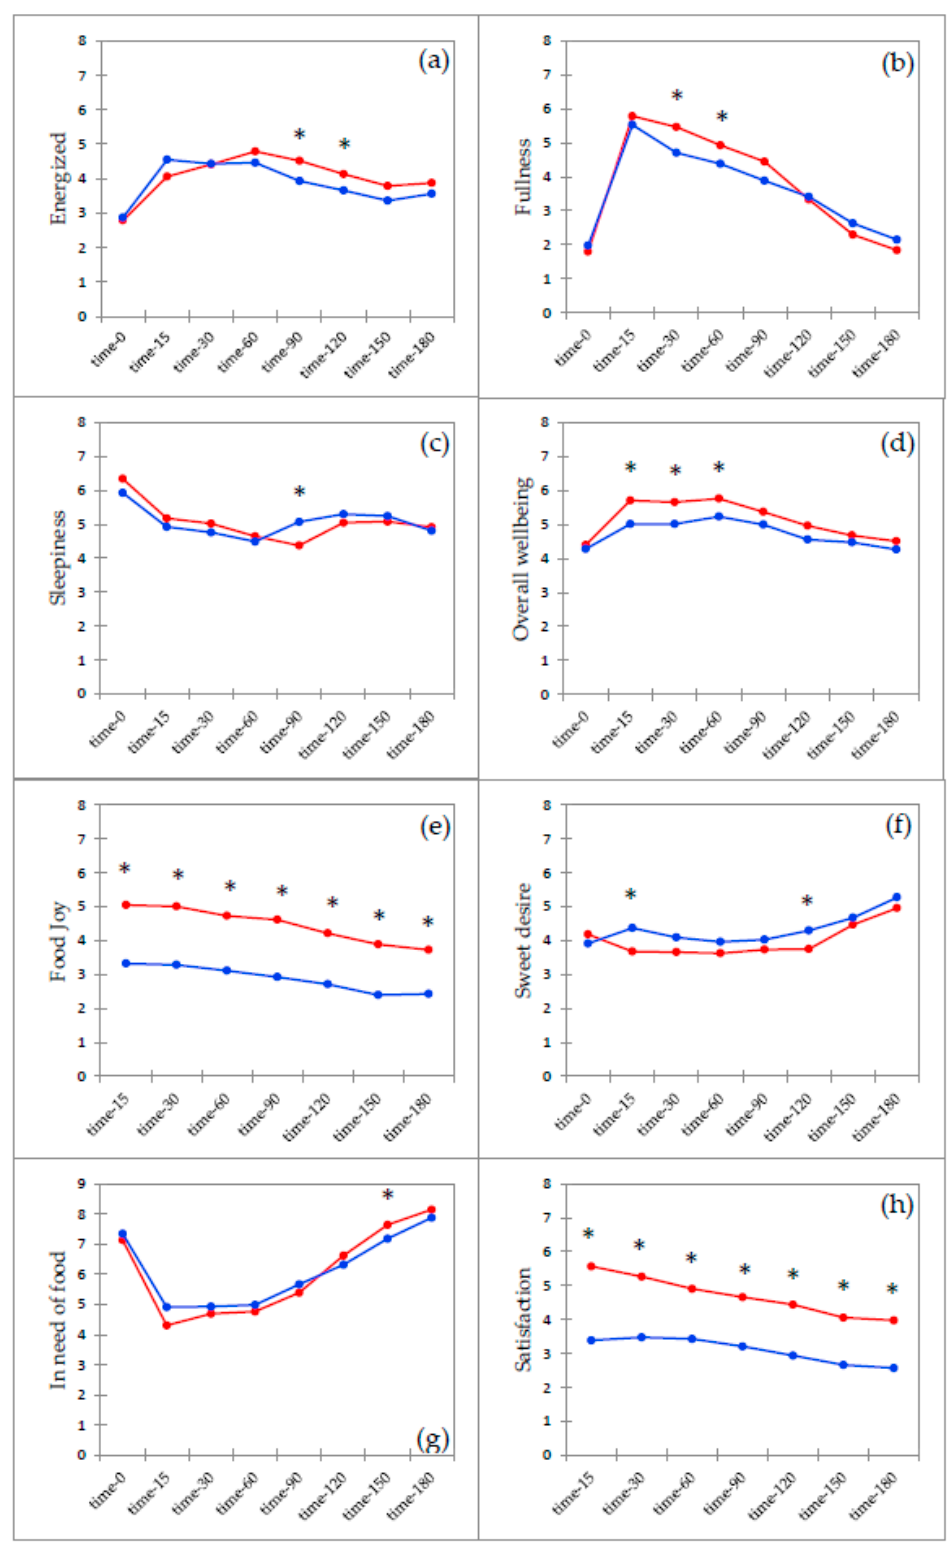
Figure 2. Post-ingestive responses at time-0 (pre intake),15,30,60,90,120,150,180 for Energized ( a ), Fullness ( b ), Sleepiness ( c ), Overall wellbeing ( d ), Food joy ( e ), Sweet desire ( f ), In need of food ( g ), Satisfaction ( h ). Red = High-carbohydrate test meal, Blue = High-protein test meal. Asterisk (*) indicates significant difference between the two test meals for the specific time point ( p < 0.05).